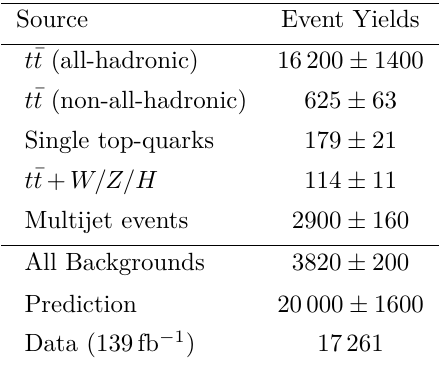
Table 2 . Event yields in the signal region for the expected t ¯ t signal process and the background processes. The sum of these is compared with the observed yield. The uncertainties represent the sum in quadrature of the statistical and systematic uncertainties for each process, as described in section 8. Neither t ¯ t modelling uncertainties nor uncertainties in the inclusive t ¯ t cross-section are included in the systematic uncertainties. The multijet-background uncertainty includes the statistical uncertainties in the signal and control regions as well as the systematic uncertainties arising from the MC-based subtraction in the control regions used to make the data-driven estimate. The column entries do not add up exactly to ‘All Backgrounds’ and ‘Prediction’ due to